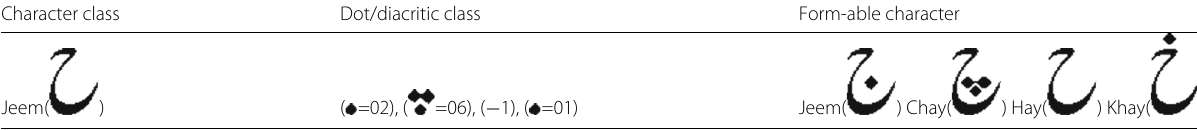
Table 7 Sample character class with respective dot/diacritics values forming characters Character